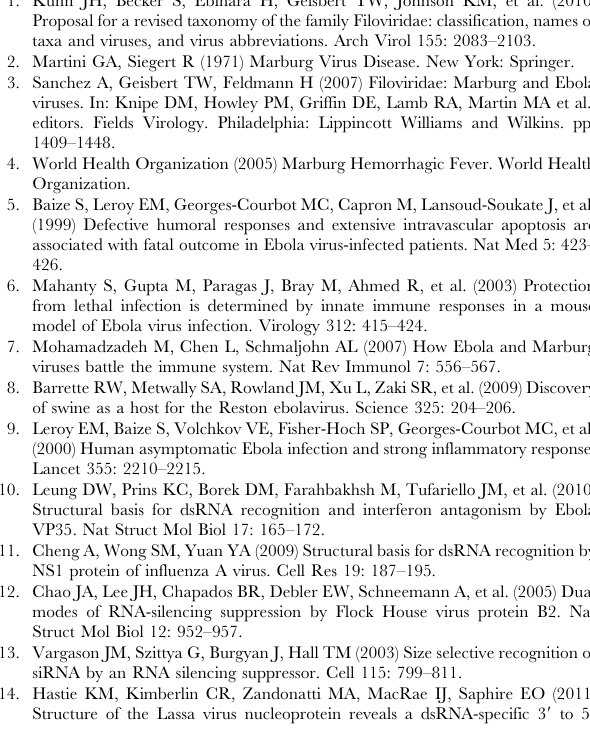
Figure S4 Dot blot binding assay of (A) EBOV VP35 RBD and (B) RESTV VP35 RBD binding to 18-bp blunt ended dsRNA. (C) MARV, EBOV and RESTV VP35 RBD binding to 18-bp dsRNA with 3 9 overhang. The K d and Hill coefficients of binding are shown in Table 3. (TIF) Figure S5 2D-NOESY spectrum comparing wild-type MARV VP35 RBD (shown in black) to the F228 mutant (shown in red). The overlay of the spectrum suggests that no global conformational changes occur upon the F228A mutation. (TIF) Figure S6 Control ITC binding isotherms for (A) Buffer dilution to 18-bp dsRNA; (B) MARV VP35 RBD titrated into 18-bp single stranded RNA.